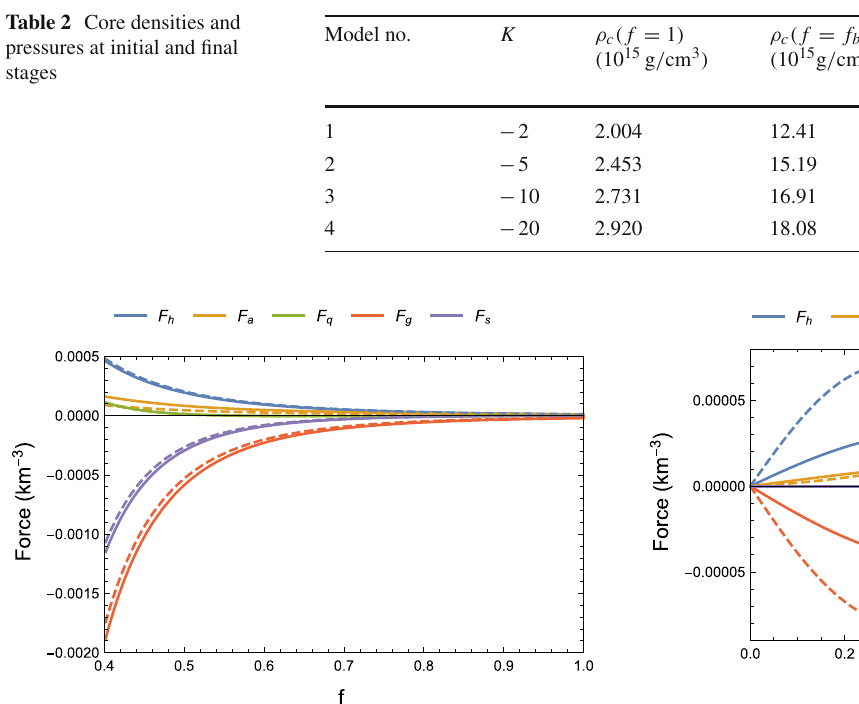
Fig. 2 Force profiles at f = 1 for K = − 2 (solid) and K = − 20 (dashed)